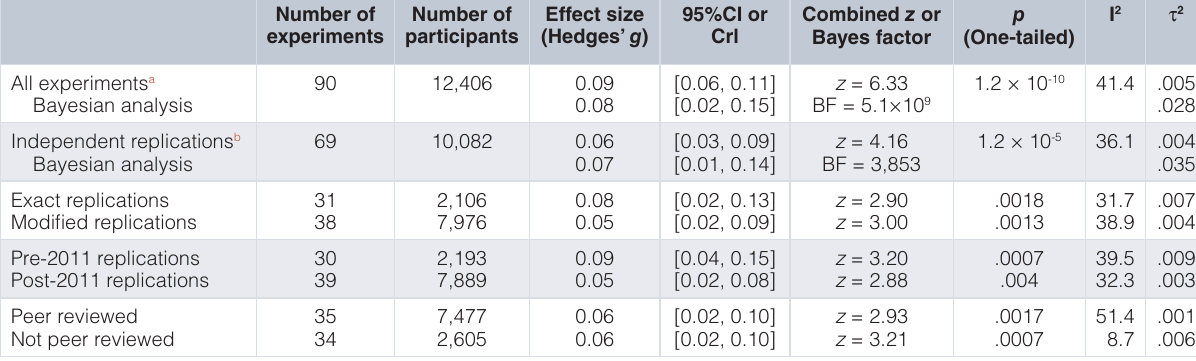
Table 1. Meta-analytic results for all experiments and for independent replications of Bem’s